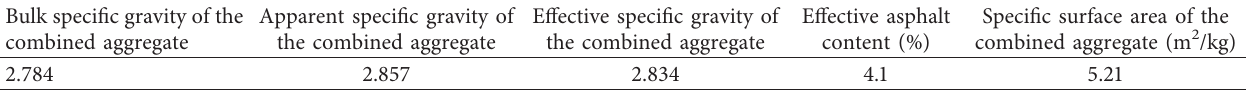
Table 7: Information for the calculation of the effective film thickness of the control